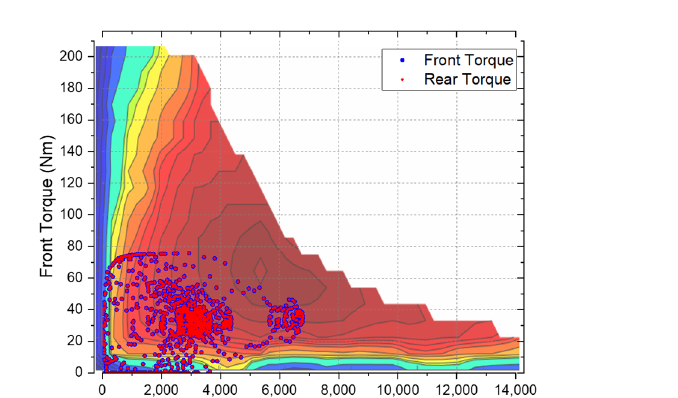
Figure 9. Efficiency gains versus conventional 4 WD: ( a ) Gear ratio 10:1, ( b ) Gear ratio 8:1, ( c ) Gear ratio 7:1, ( d ) Gear ratio 6:1.